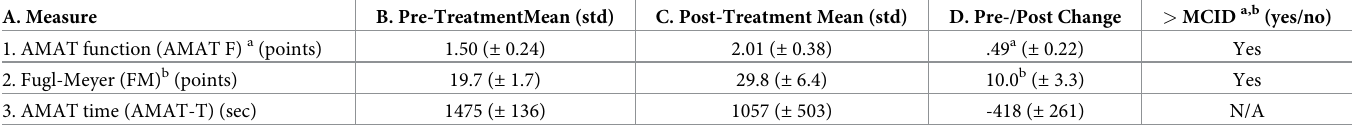
Motor outcome measures. Group descriptive statistics are provided in Table 2. The pri- mary measure, mean improvement in AMAT-F, functional task performance, was just above the MCID of .44 for the AMAT-F (Table 2, row 1, column D), indicating clinically significant improvement. Three of four subjects had a clinically significant improvement in AMAT-F by Table 2. Group data for motor